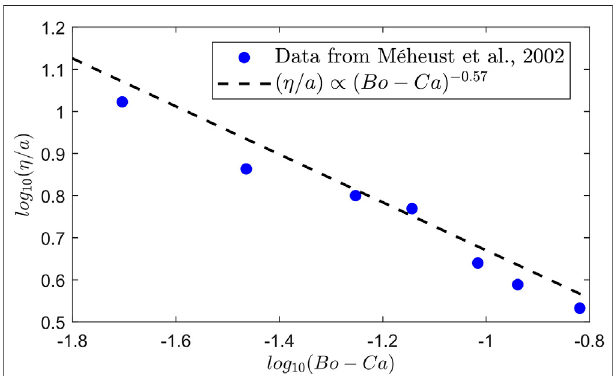
FIGURE 10 | The dependence of the front width η / a on the generalized Bond number Fa /( c N ( p c )) (cid:1) Bo − Ca . The blue dots correspond to data taken from [61] where the Bond number Bo (cid:1) Δ ρ ga 2 / c (cid:1) 0.154 is kept fi xed but the capillary number Ca (cid:1) q μ 2 a 2 /( c kA ) is changed by varying the fl ow rate q .